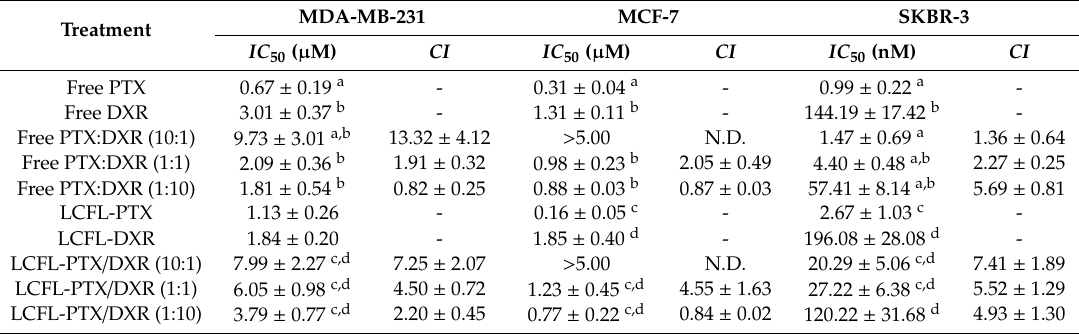
Table 2. Values of IC 50 and CI obtained for the di ff erent cell lines evaluated when exposed to di ff erent ratios of free or liposome co-encapsulated PTX and DXR for 48 h. MDA-MB-231 MCF-7 SKBR-3 Treatment IC 50 ( µ M) CI IC 50 ( µ M) CI IC 50 (nM) CI Free PTX 0.67 ± 0.19 a - 0.31 ± 0.04 a 0.99 ± 0.22